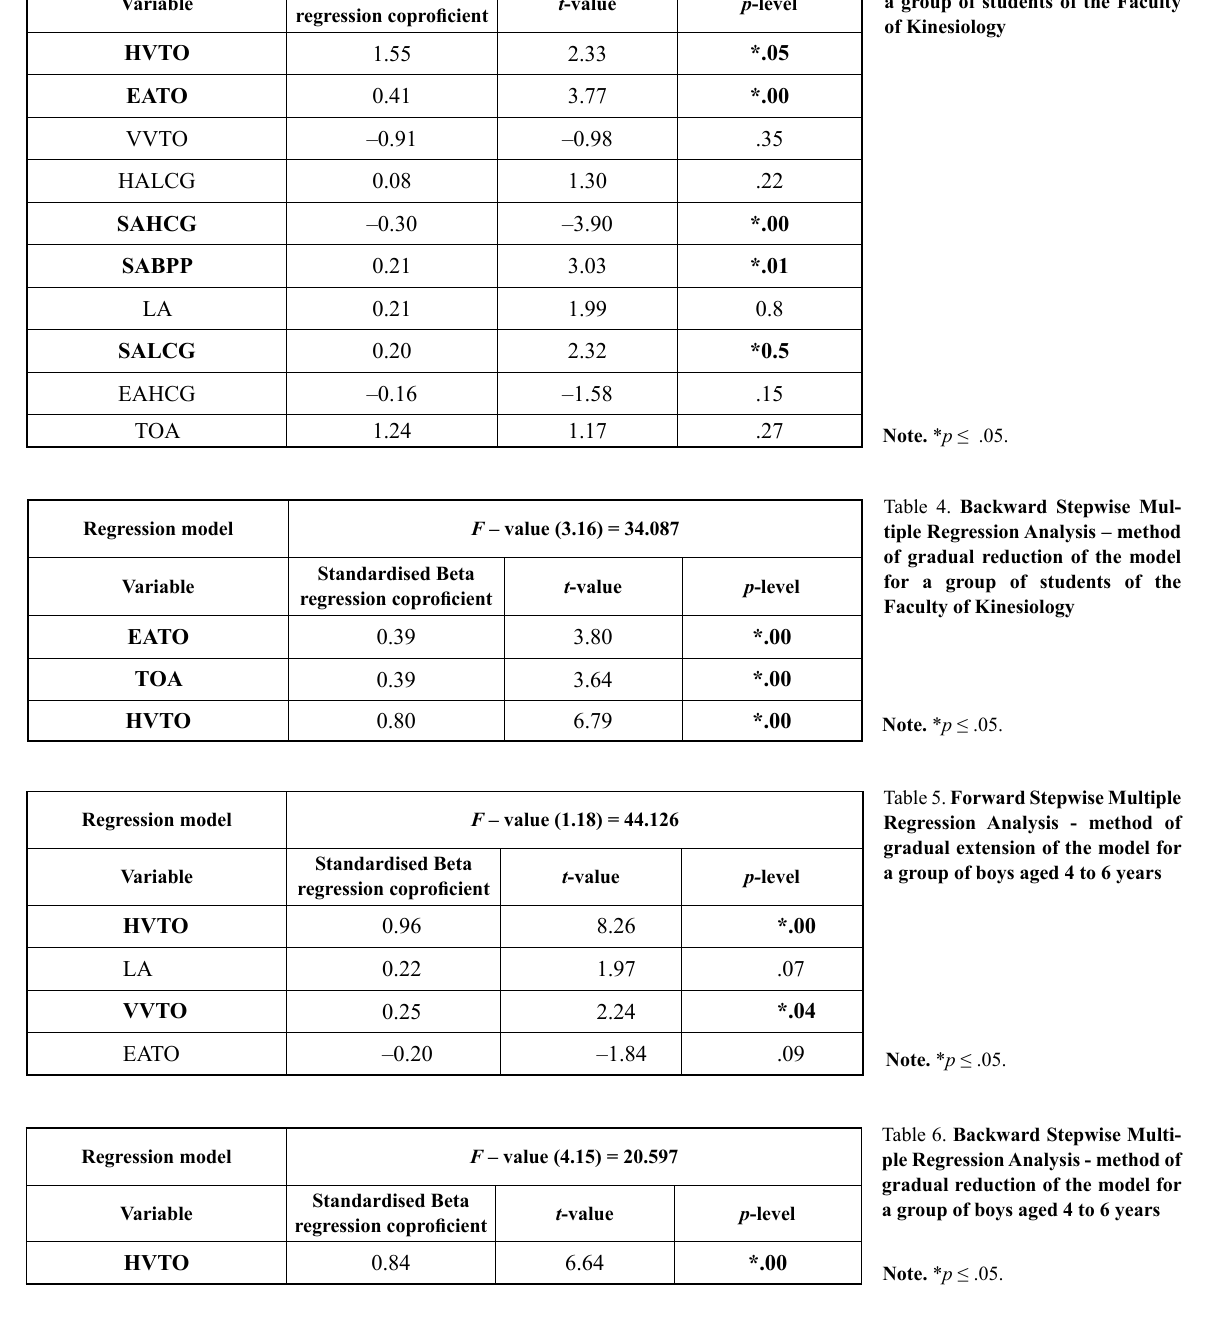
Table 6. Backward Stepwise Multi